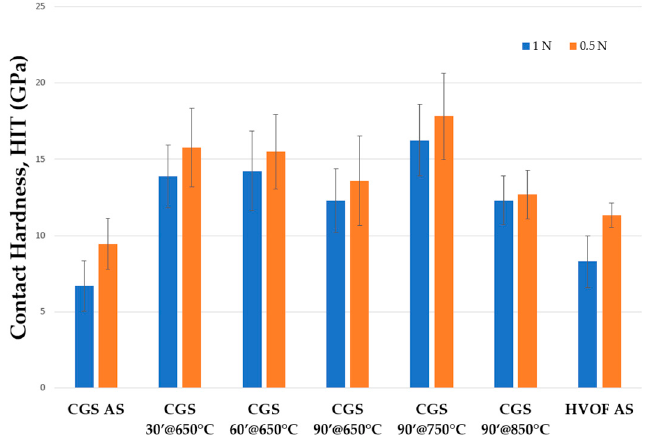
Figure 9. Contact hardness (HIT) of GGS and HVOF coatings, before (AS, as-sprayed) and after heat treatment, as measured by dynamic indentation.